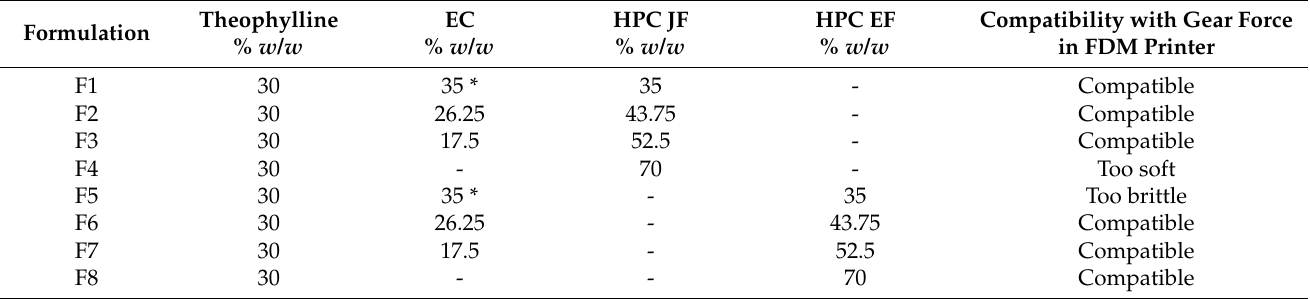
Table 1. Composition of proposed formulations and their compatibility with the FDM printer.